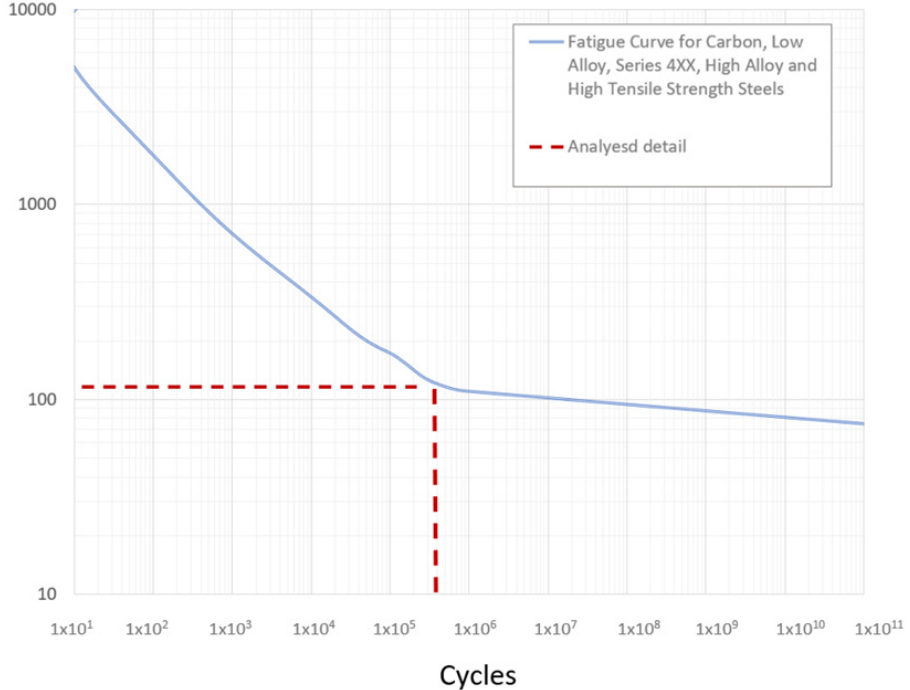
Figure 12. Fatigue life of the analysed detail [12].